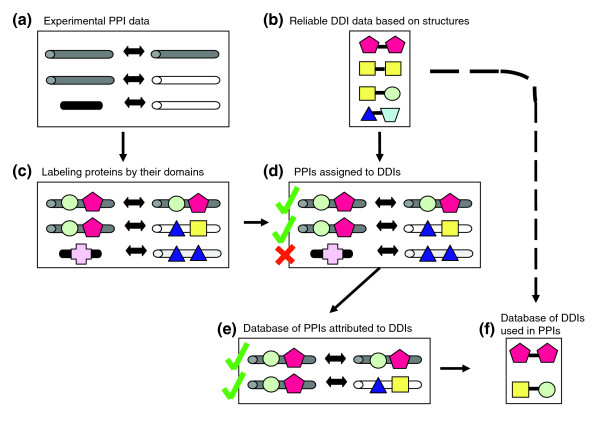
A schematic description of the analysis. (a) A list of experimentally determined PPIs is compiled for each of the five organisms (E. coli, S. cerevisiae, C. elegans, D. melanogaster, and H. sapiens) from INTACT [32], DIP [19], and BIOGRID [33]. (b) A list of structurally derived DDIs is compiled from 3DID [12] and iPfam [13] databases. (c) The appropriate domains are assigned to each of the interacting proteins according to the definitions of the InterPro database [34]. (d) Based on the data complied in panels b and c, DDIs are mapped onto PPIs. (e) A list of PPIs with DDI assignments is compiled. (f) A list of the DDIs mapped onto PPIs is compiled. DDI, domain-domain interaction; PPI, protein-protein interaction.